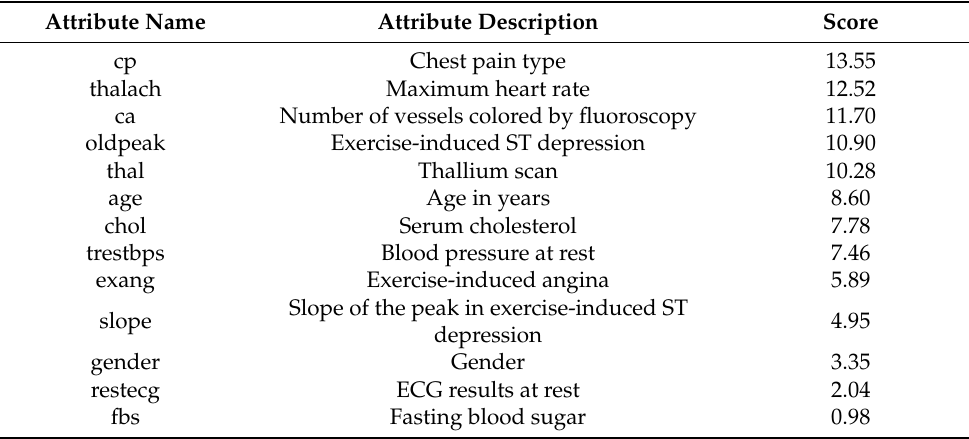
Table 3. Selected attributes from the Cleveland dataset with Random